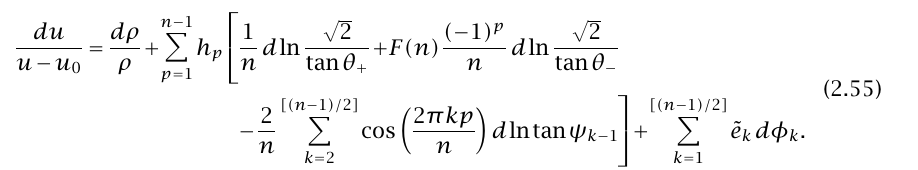
Figure 2.3 . Integration path Γ and pole u 0 , and their projections Γ ξ on the plane ξ k η k u 0 ξ k η k